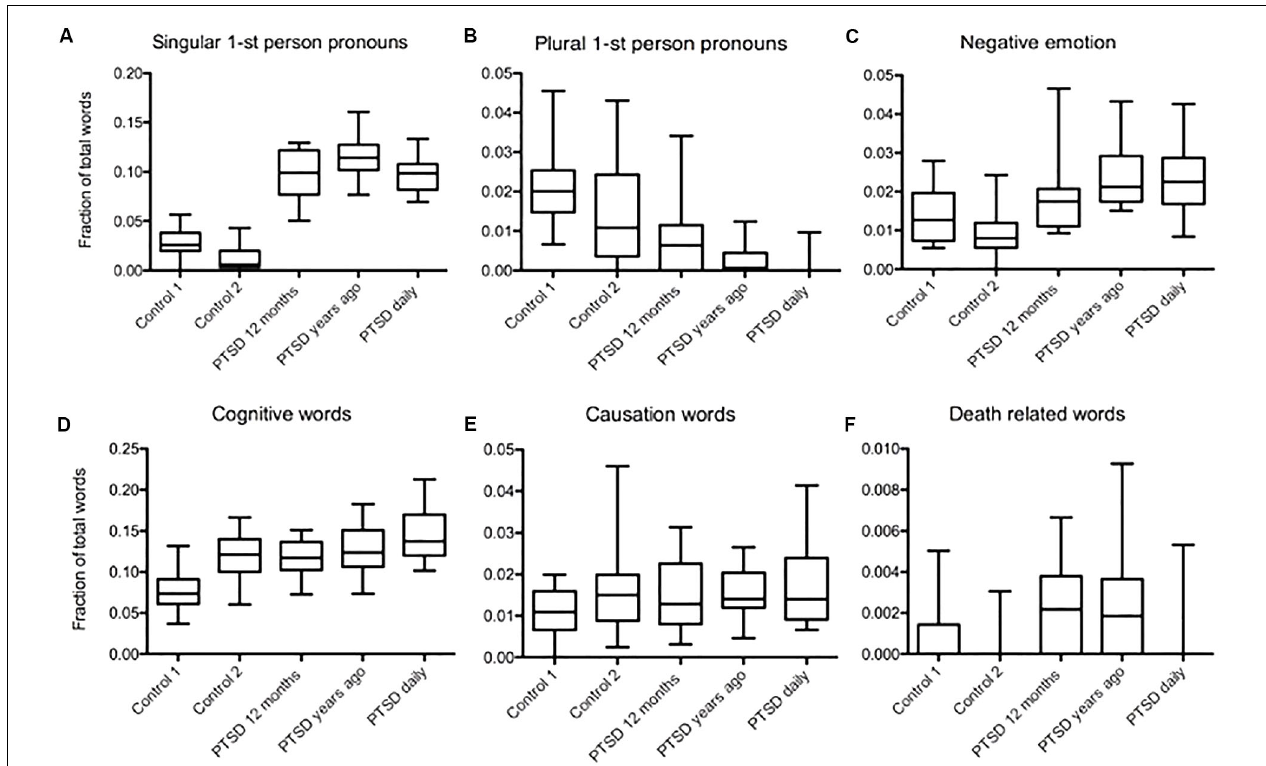
FIGURE 3 | Word usage patterns in daily narratives and trauma related narratives of PTDS sufferers. (A) Higher frequency of singular first-person pronouns in both PTSD related text types compared to controls, the highest one found in the trauma narratives by individuals whose trauma occurred years ago (Mdiff = 0.067, Mdiff = 0.087, Mdiff = 0.069, p < 0.001; Mdiff = 0.0827, Mdiff = 0.102, Mdiff = 0.0844, p < 0.001). (B) Lower usage of plural first-person pronouns in daily narratives compared to recent trauma related text occurrence (Mdiff = 0.0063, p < 0.05). However, all three PTSD groups used fewer plural first-person pronouns than control 1, but compared to control 2 only the recent trauma group and daily narratives showed a significant difference (Mdiff = 0.019, Mdiff = 0.014, Mdiff = 0.02, p < 0.001; Mdiff = 0.0069, Mdiff = 0.0133, p < 0.001, Mdiff = 0.012, p > 0.05). (C) Negative emotion word frequency was highest in daily narratives, but it was also high compared to controls in the reports of trauma that occurred years ago (Mdiff = 0.008, p < 0.05; Mdiff = 0.0135, p < 0.05; Mdiff = 0.009, p < 0.05, Mdiff = 0.015, p > 0.05). (D) Cognitive word frequency was the highest in daily narratives of PTSD sufferers. In all three PTSD groups, it was higher than in control 1, but not significantly higher than in control 2 (Mdiff = 0.039, Mdiff = 0.049, Mdiff = 0.066, p < 0.001; p > 0.05). (E) There was no significant difference in causation word usage between PTSD groups and controls ( p > 0.05). (F) Death related word type usage was increased in both trauma text types compared to only control 2 but not compared to control 1, daily narratives didn’t differ significantly compared to both controls (Mdiff = 0.0019, Mdiff = 0.0023, p < 0.05; p > 0.05; p >